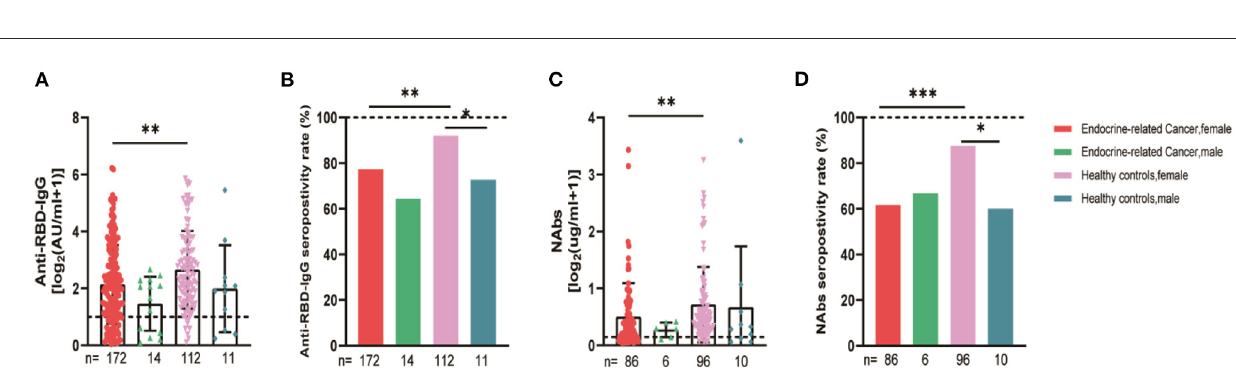
FIGURE4 Antibody responses to inactivated SARS-CoV-2 vaccines in participants’ gender. Subgroup analysis of the titers and seropositivity rate of anti-receptor binding domain (RBD)-IgG (A, B) and NAbs (C, D) in participants according to gender (* P < 0.05, ** P < 0.01, *** P < 0.001). The horizontal dotted lines represent the limit of detection. The error bars represent the median (IQR). NAbs, neutralizing antibodies; IQR, interquartile range; RBD, receptor binding domain.